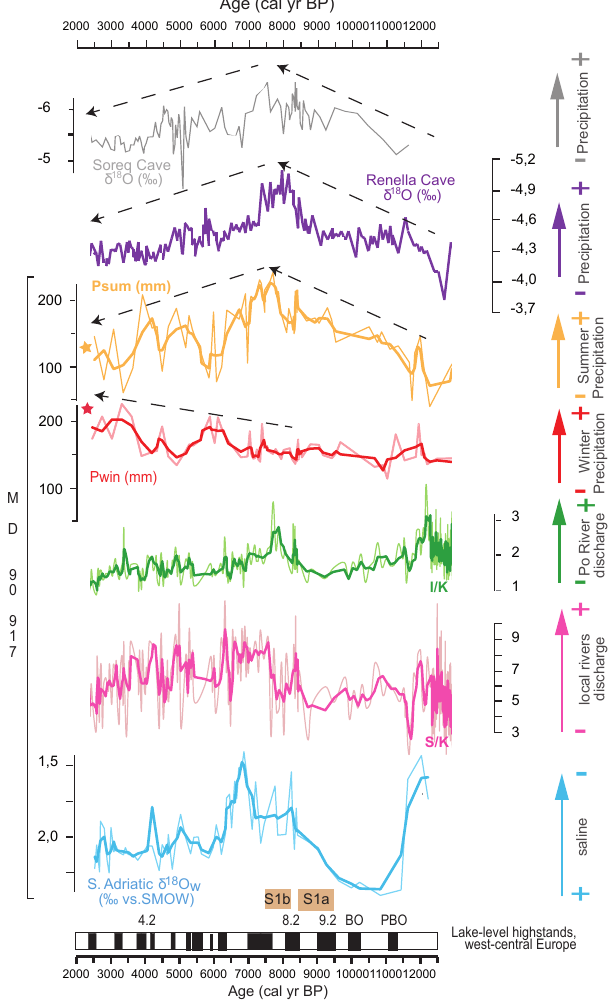
Fig. 9. Comparison of the Psum (yellow) and Pwin (red) precipita- tion changes reconstructed from MD 90-917 pollen data (MAT) and from bottom to top: lake level highstands in western Europe (Magny et al., 2012 column); sea surface salinity reconstructed from MD 90-917 δ 18 O record (Siani et al., 2013; blue), I/K (pink) and S/K (green) ratios from MD 90-917 and δ 18 O speleothem records from the Renella cave (Italy) (Zhornyak et al., 2011; purple) and Soreq cave (Israel) (Bar-Matthews et al., 1998; Bar-Matthews and Ayalon, 2011; grey). For MD 90-917 records, thin, light curves represent the original data and accentuated curves are the 3 pts-smoothed